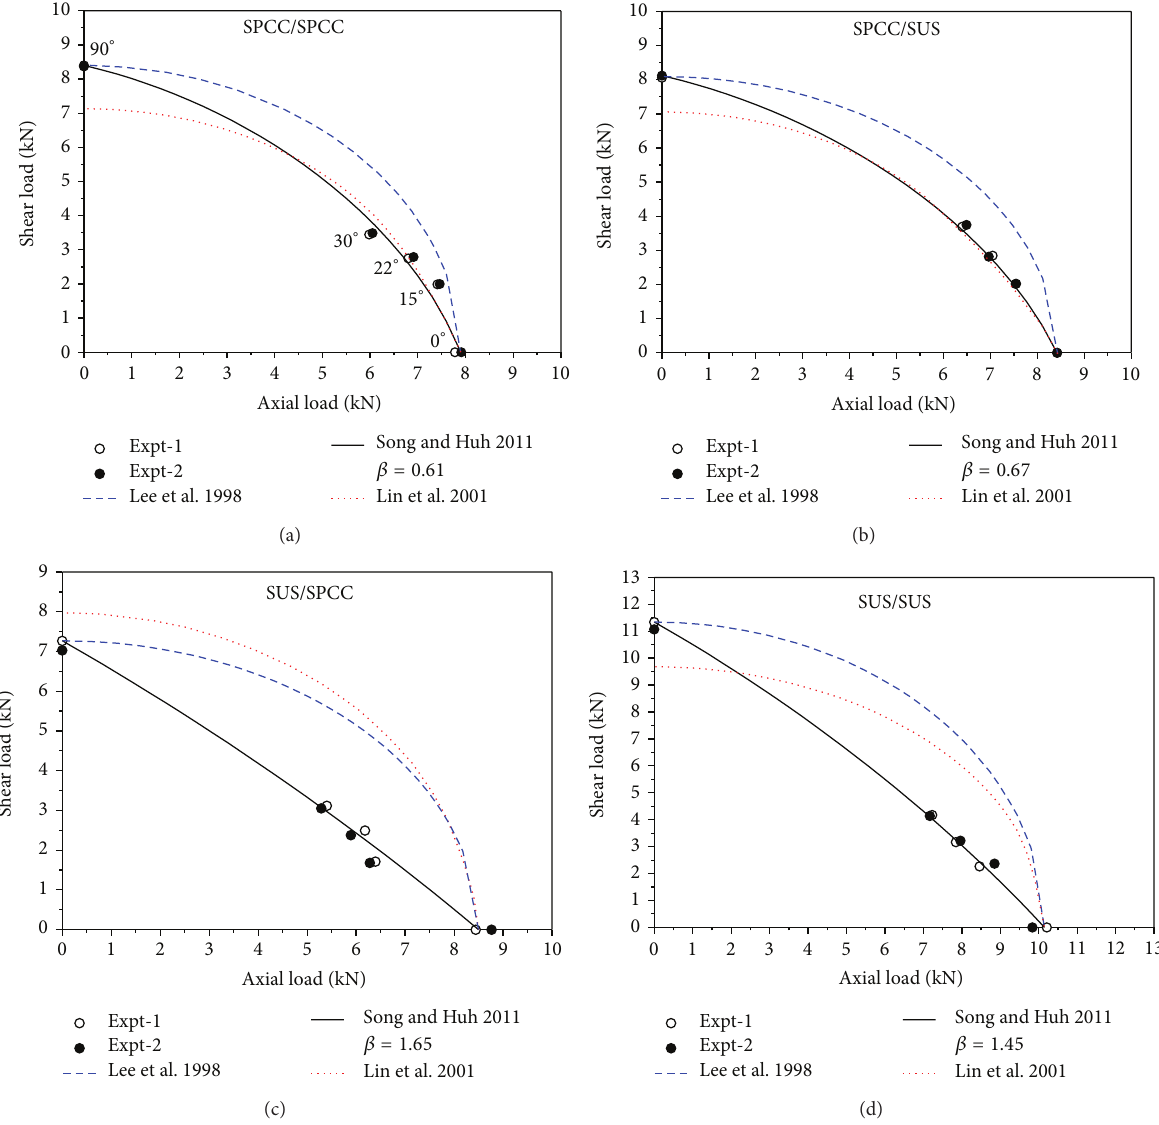
Figure 11: Comparison of the experimental result with conventional failure criteria: (a) SPCC/SPCC, (b) SPCC/SUS, (c) SUS/SPCC, and (d)